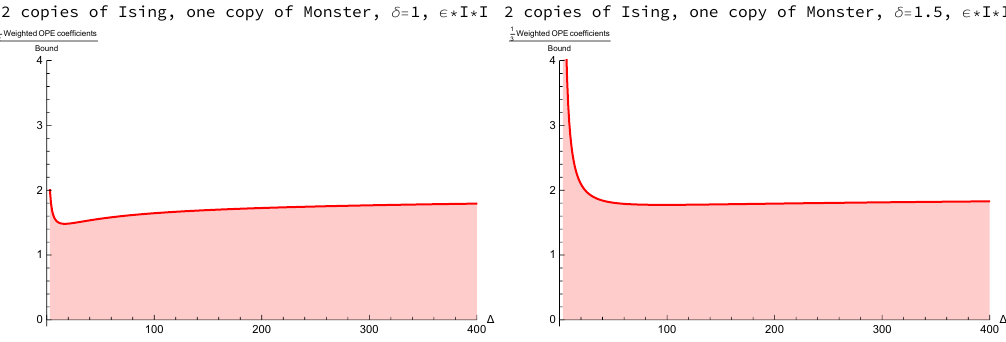
= 2, for low values (cid:13)